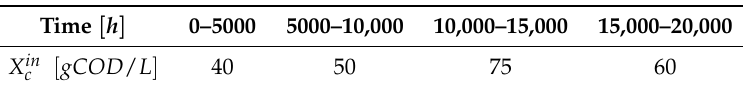
Figure 9. Dynamic behavior of the model solutions with variable D 1 from Table 3. Table 4. Values of X in c